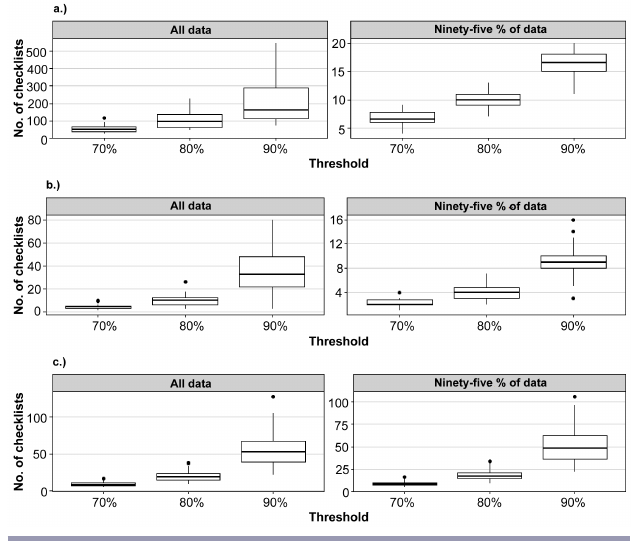
Fig. 1 . The number of checklists (2010–2016), necessary to meet 70%, 80%, and 90% thresholds for 30 sites throughout Canada and the United States (Table A1.1) for (a) species richness, (b) Shannon diversity, and (c) community composition (Bray-Curtis similarity). Separate analyses are provided for the full dataset, and for those species recorded on > 5% of all checklists at the site.